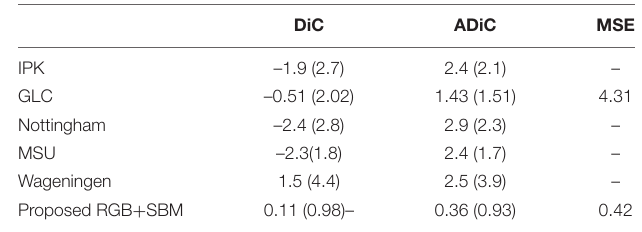
TABLE 4 | Counting results using different backbones with or without the auxiliary binary mask on CVPPP 2017 dataset (Bold values denote the best performance).